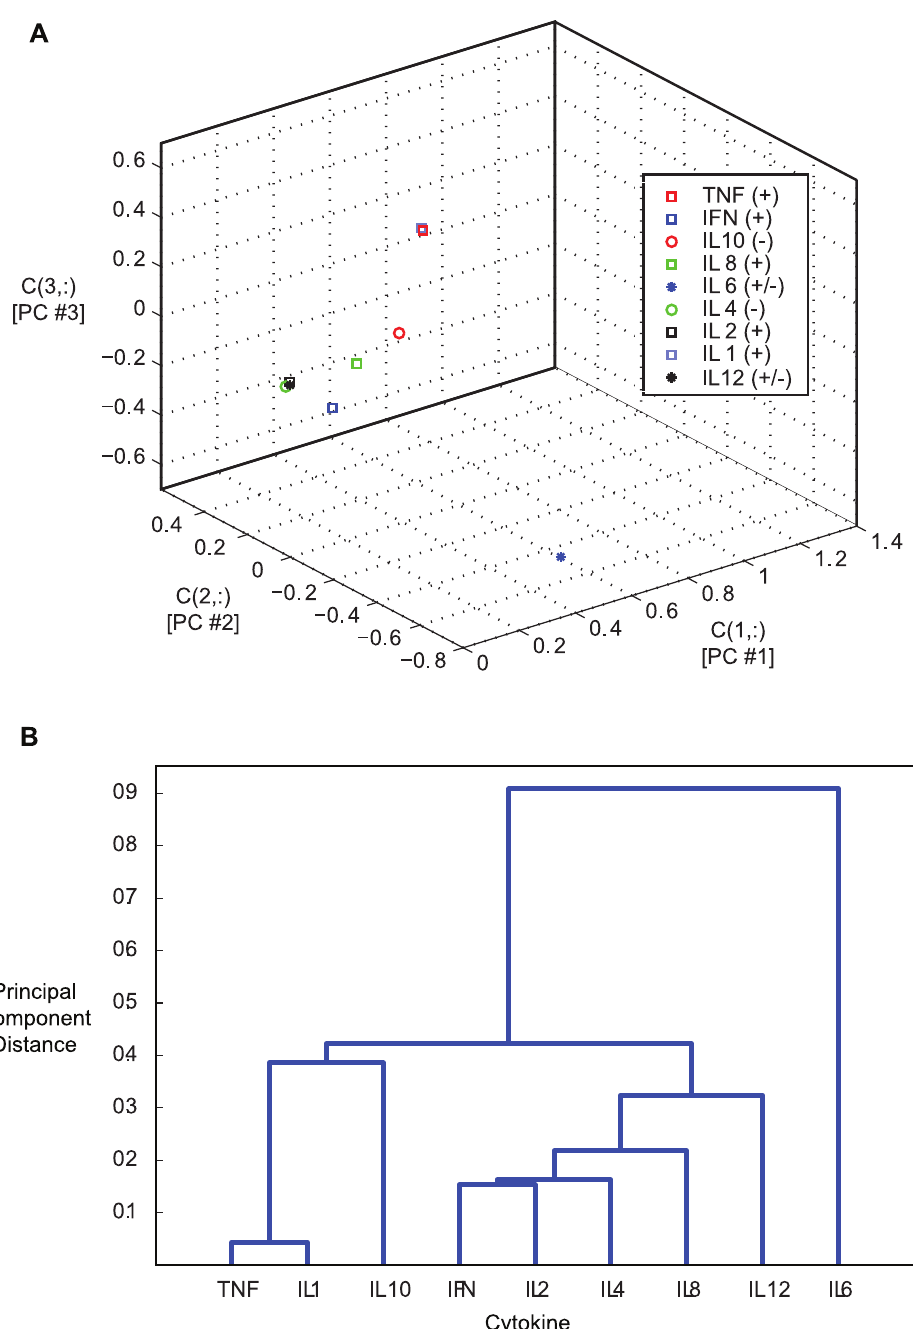
Figure 8. Similarity of cytokine response shapes as described by the first three principal component coefficients. A) Coefficients of the first three principal components. B) Dendrogram relating closeness of cytokine